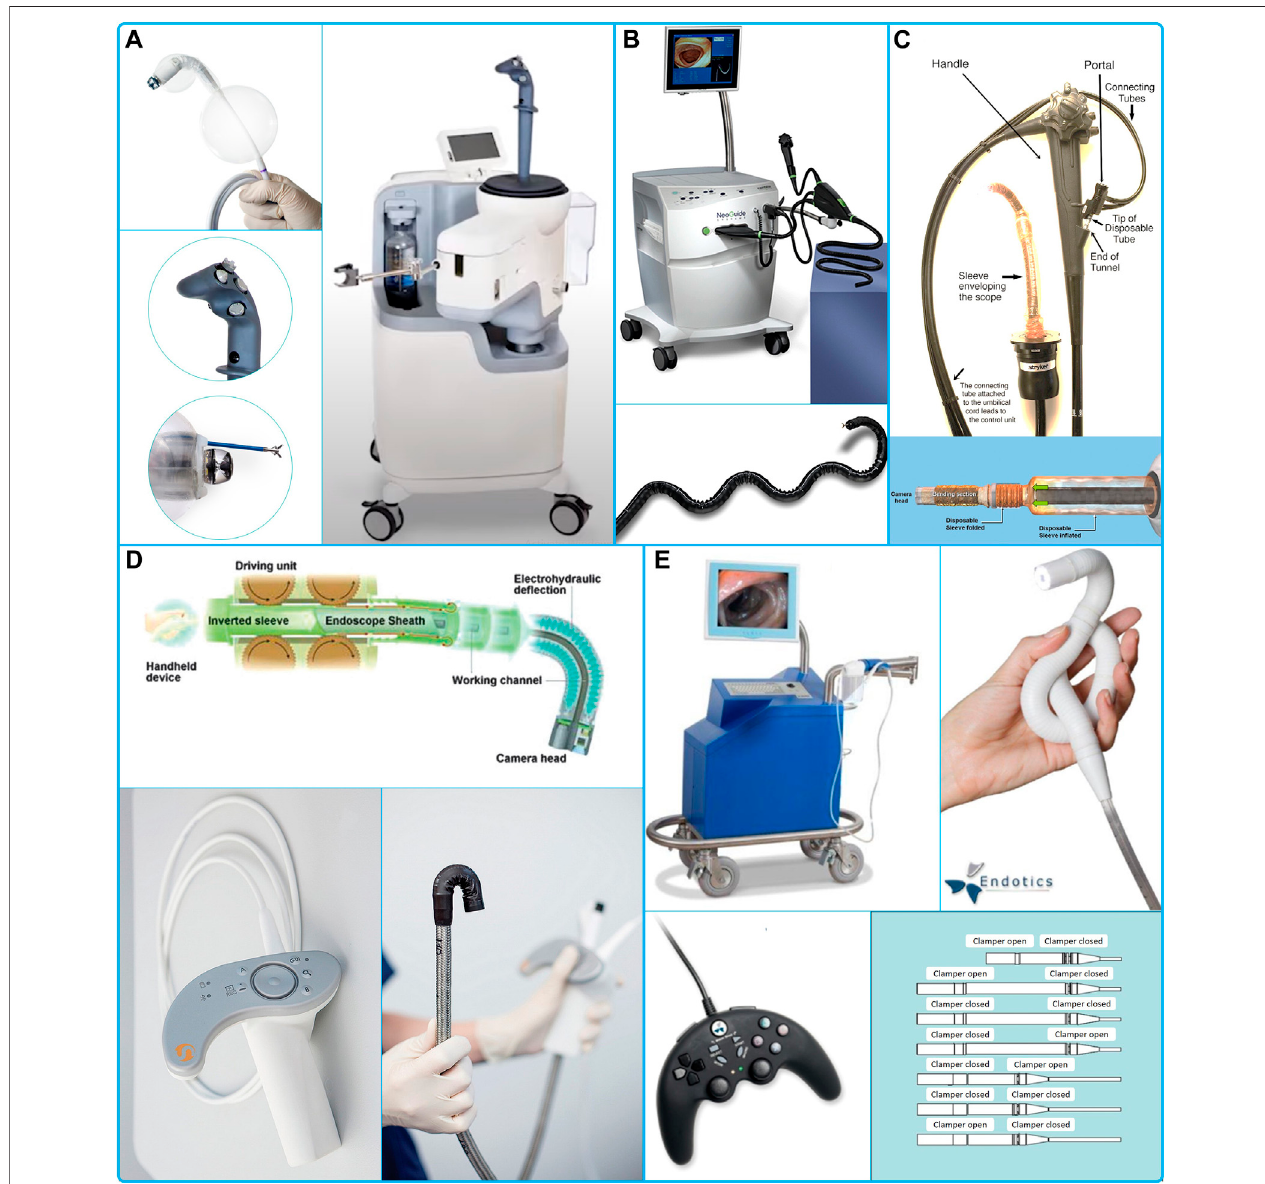
FIGURE 2 | (A) Aer-o-Scope GI-View (Aer-O-Scope Colonoscope, 2021), (B) Neoguide System (Karimyan et al., 2009), (C) ColonoSight (Sightline Technologies Ltd. Haifa, Israel) (Shike et al., 2008), (D) Invendo Medical GmbH (Kurniawan and Keuchel 2017), (E) Endotics ® System from Era Endoscopy (Cosentino et al., 2011).